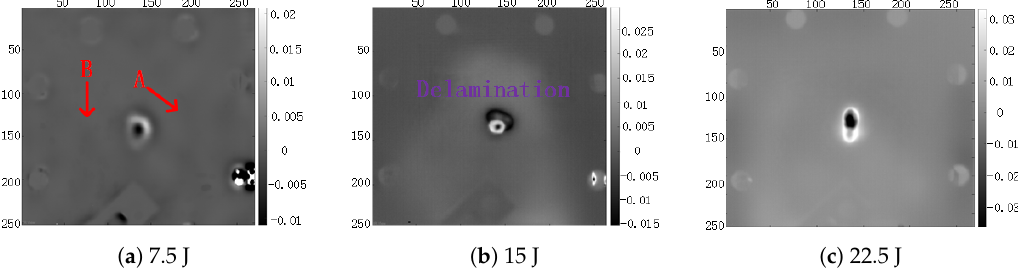
Figure 10. VT for the BFRP laminates after PCT